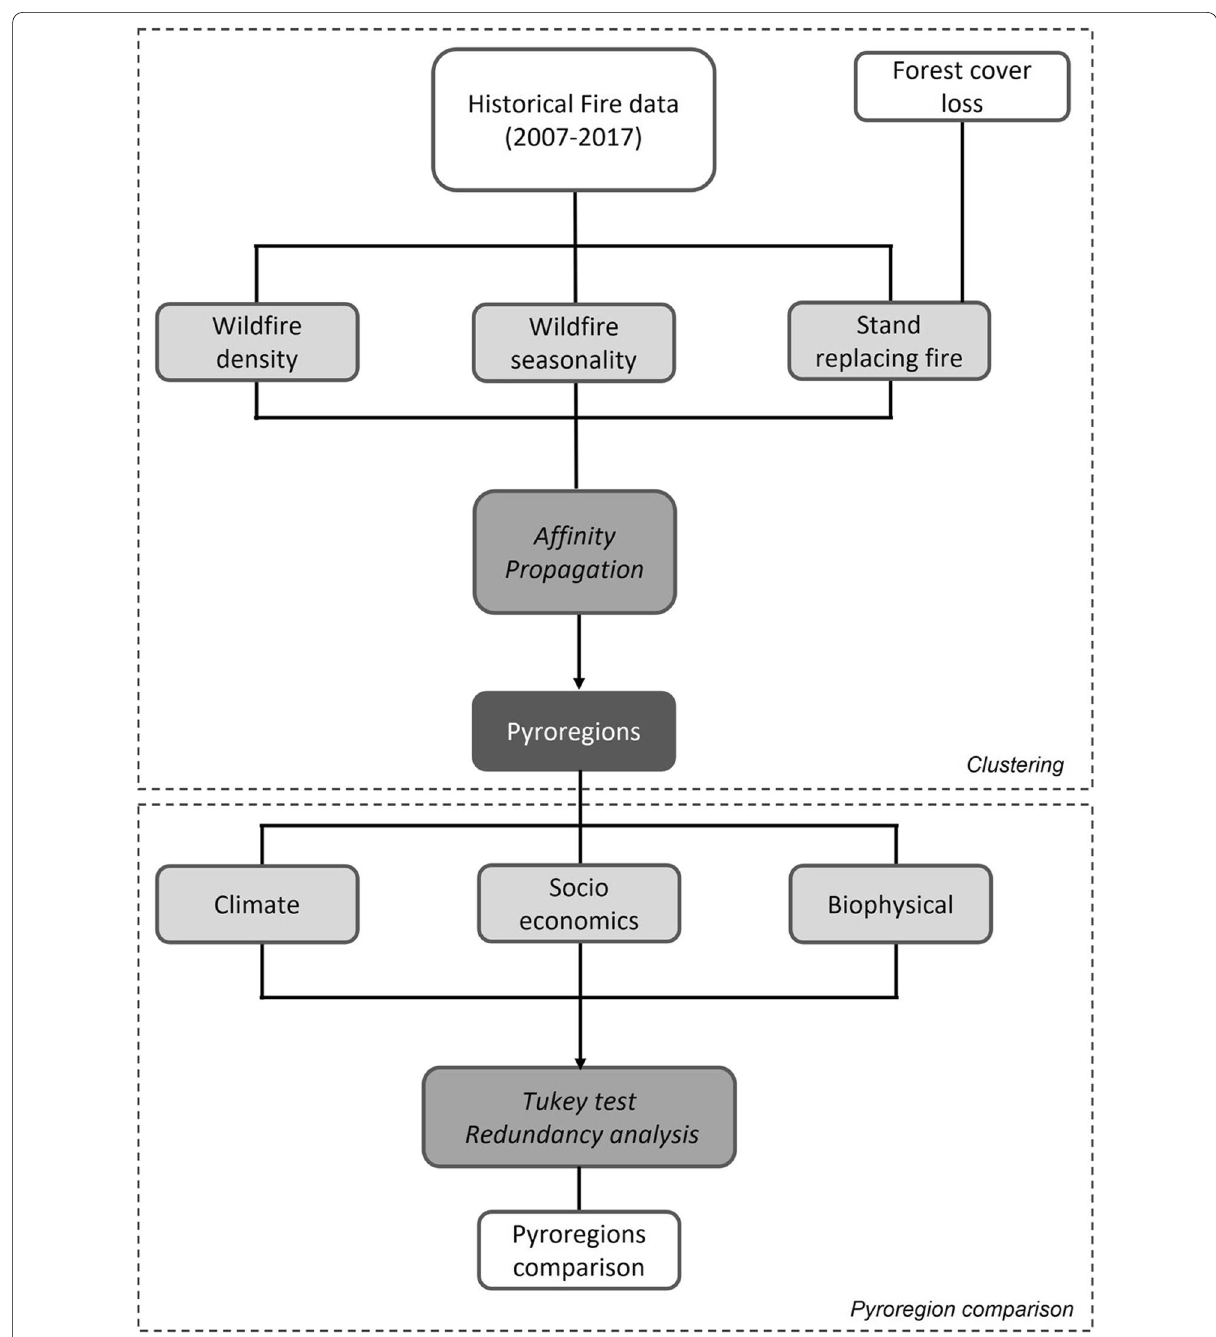
Fig. 1 Block diagram of the proposed pyrogeographic analytical